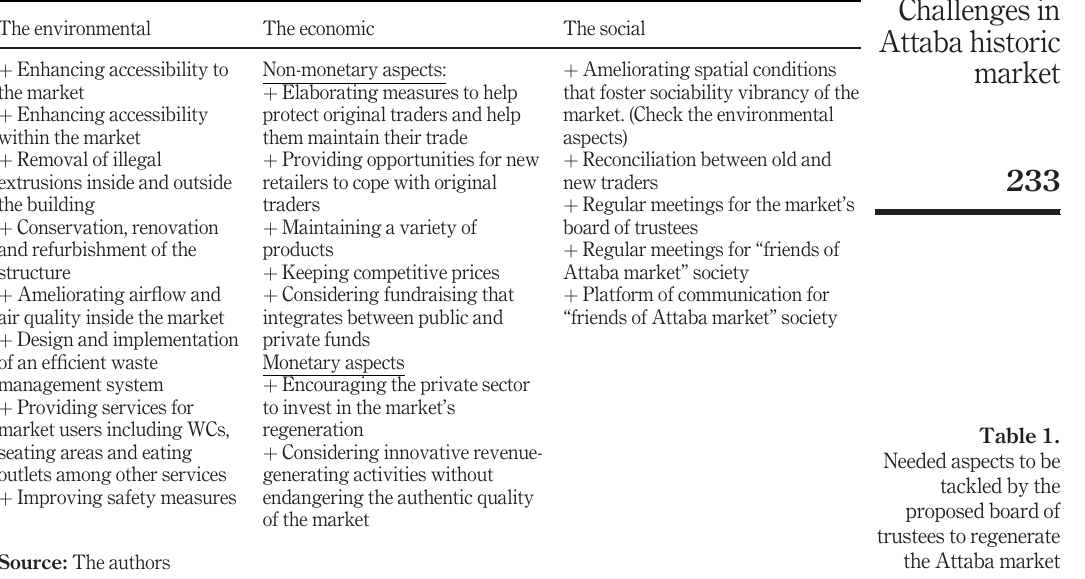
Table 1. Needed aspects to